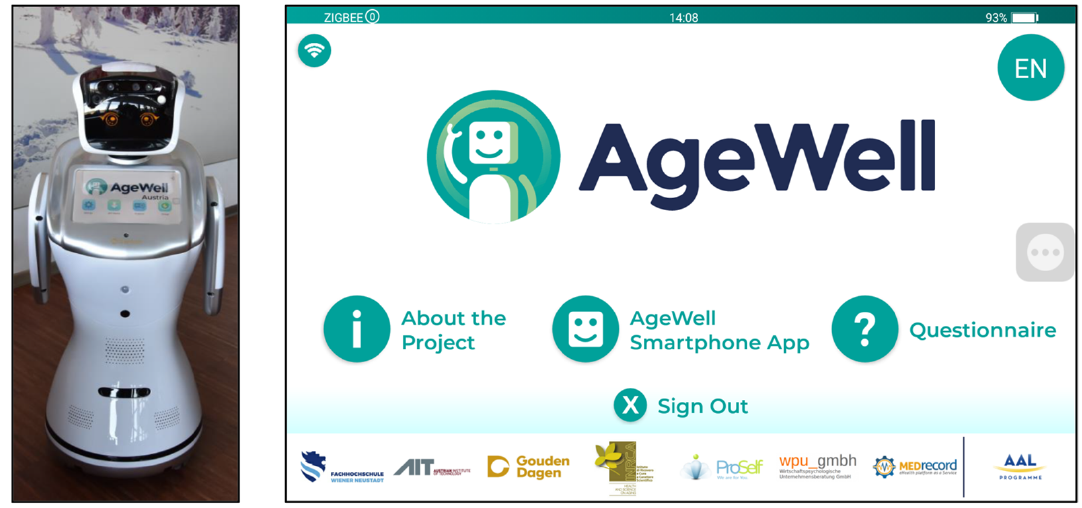
Figure 1. Sanbot Elf and main screen of the robo-coach.